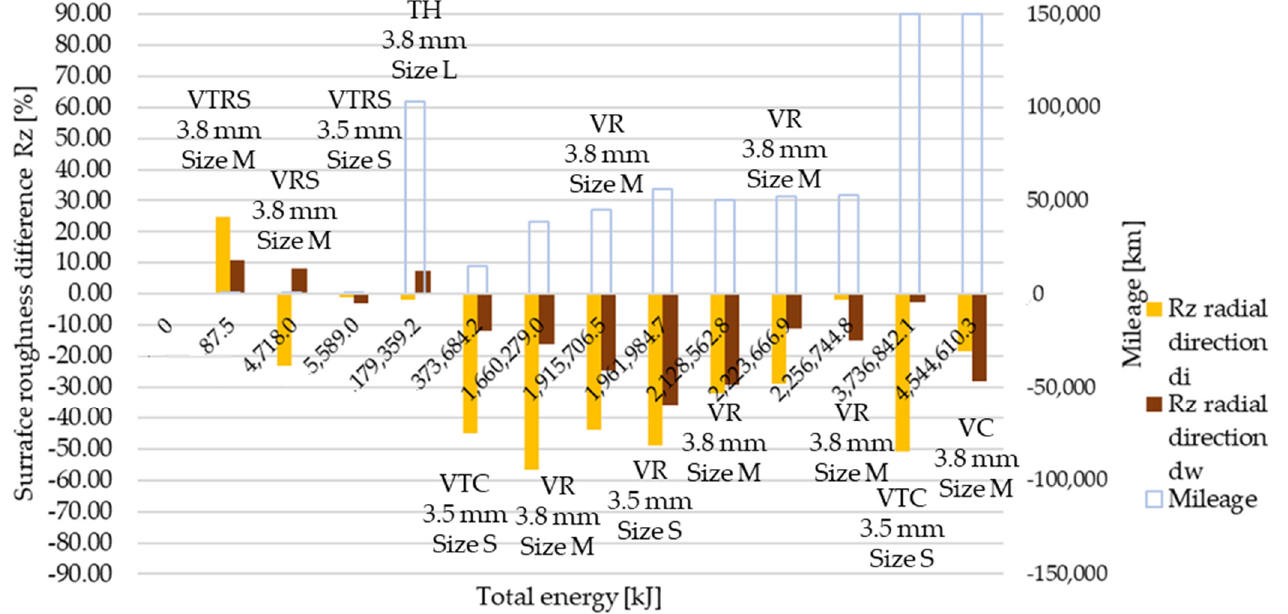
Figure 13. Deviation of Ra surface roughness values from initial conditions, tangential direction.